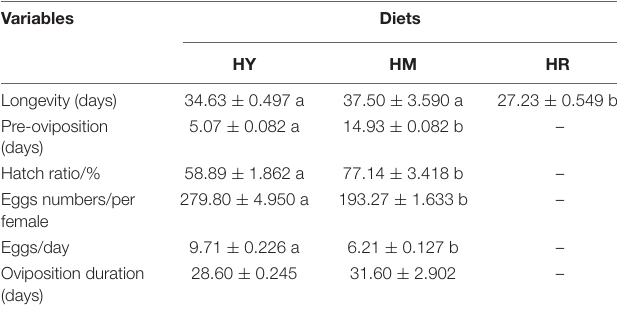
FIGURE 1 | The survival probability of H. axyridis across the life stages fed with three different diets.